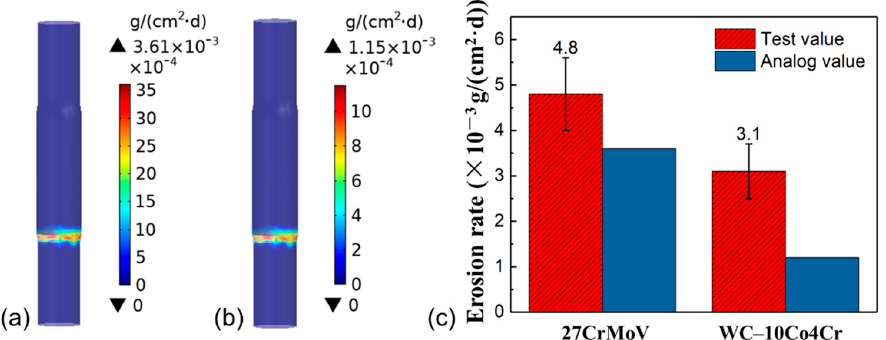
Figure 7. Erosion rate distributions of the ( a ) 27CrMoV substrate and ( b ) WC–10Co4Cr coatings for the drill pipe obtained by simulation. ( c ) Comparison of the erosion rates of 27CrMoV substrate and WC–10Co4Cr coatings obtained by simulation and experiment.